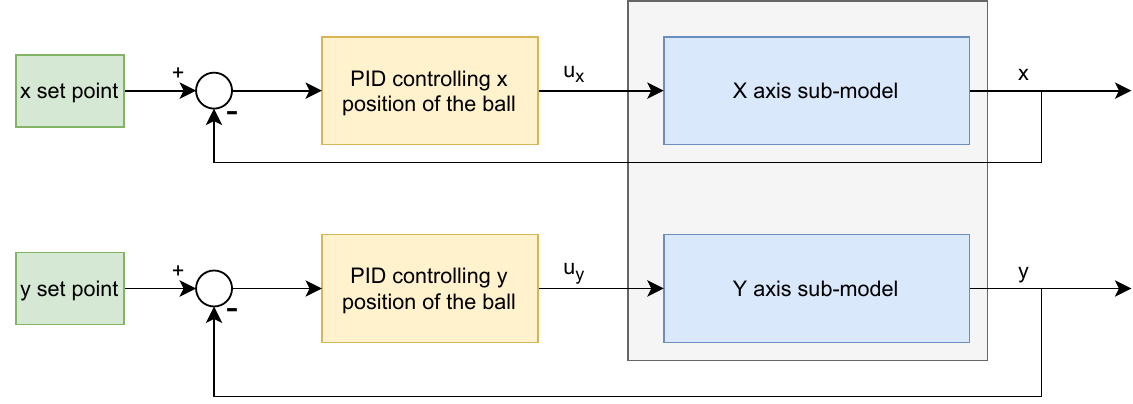
Figure 6. Diagram of the PID control structure for ball and plate